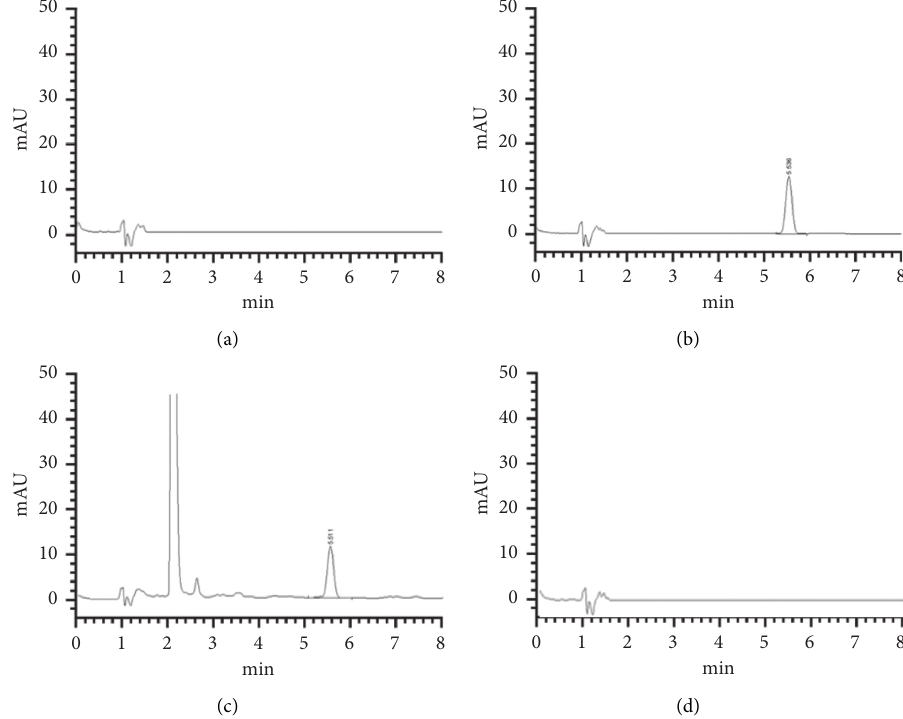
Figure 1: HPLC chromatogram of the blank solvent (a), reference standard solution of antioxidant 264 (b), sample solution of the rubber stopper (c), and recombinant potent antitumor and antivirus protein injection for the test (d).